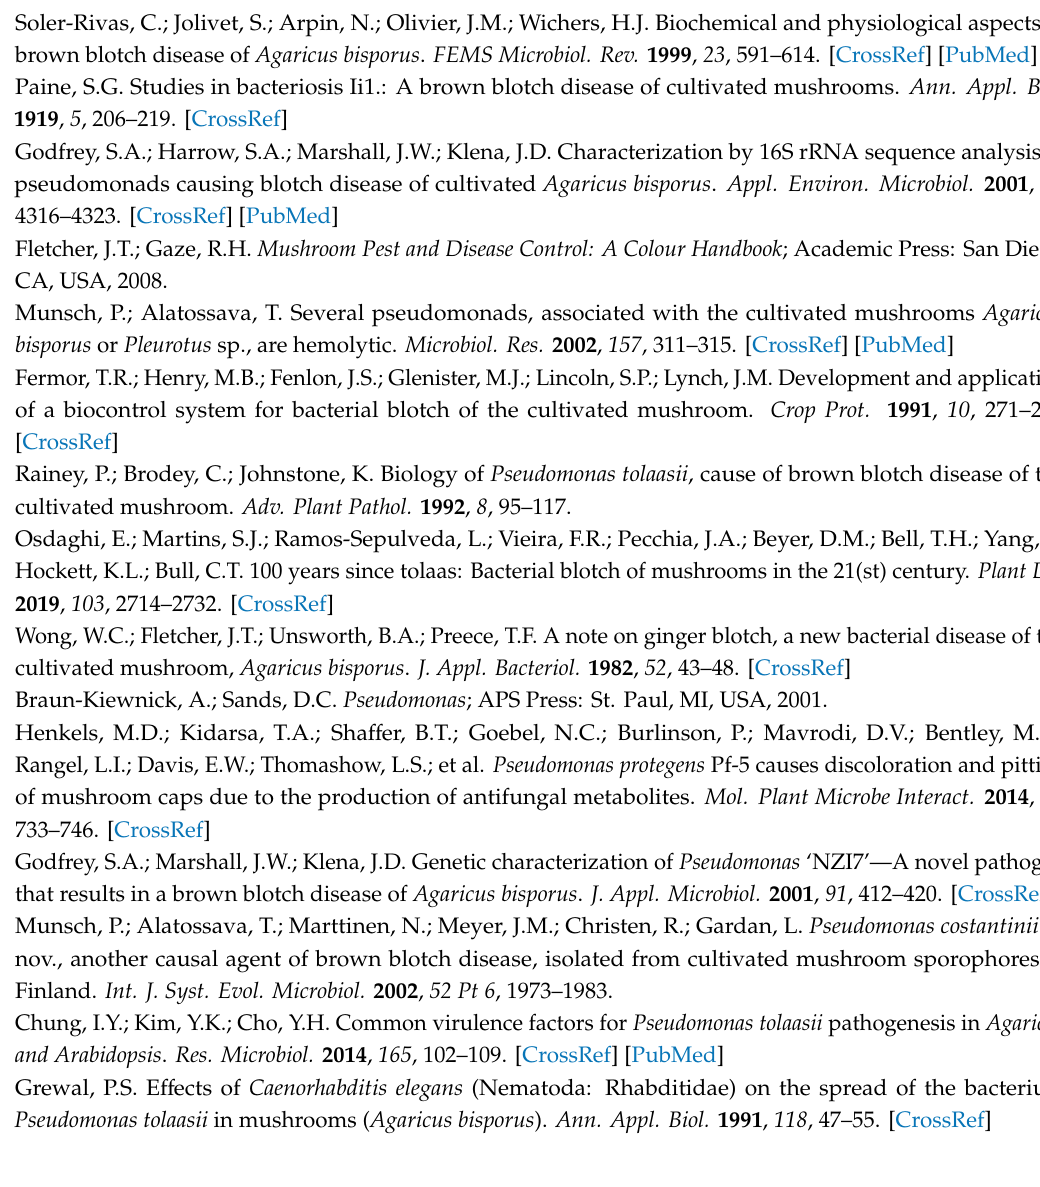
constructs in this study, Table S2: Table of all lysis protein constructs used in this study, Table S3: Plasmids used in this study, Table S4: Predicted secondary metabolites and non-ribosomal peptide synthetase in Pseudomonas tolaasii 2192T, P. agarici NCPPB 2472 and Pseudomonas sp. NS1 genome, Table S5: Predicted Type III (T3SS), IV (T4SS) and VI (T6SS) secretion systems in Pseudomonas tolaasii 2192T, P. agarici NCPPB 2472 and Pseudomonas sp. NS1 genome, Table S6: Predicted prophage in Pseudomonas tolaasii 2192T, P. agarici NCPPB 2472 and Pseudomonas sp. NS1 genome, Table S7: Predicted phage tail-like bacteriocin in Pseudomonas tolaasii 2192T, P. agarici NCPPB 2472 genome, Table S8: Predicted phage resistance systems in Pseudomonas tolaasii 2192T, P. agarici NCPPB 2472 and Pseudomonas sp. NS1 genome, Figure S1: lysis cassette of phage φ